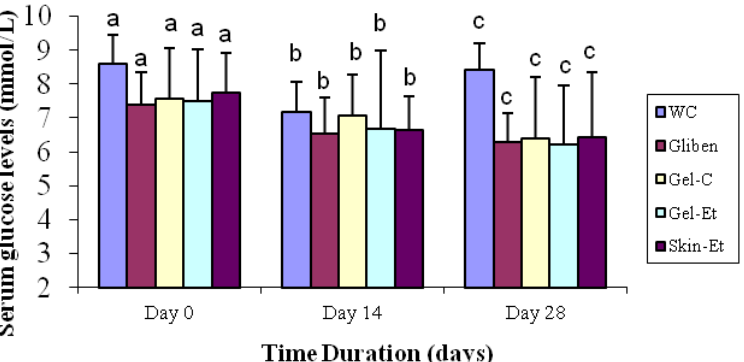
Figure 1. Effects of different treatments on the fasting serum glucose levels of type 2